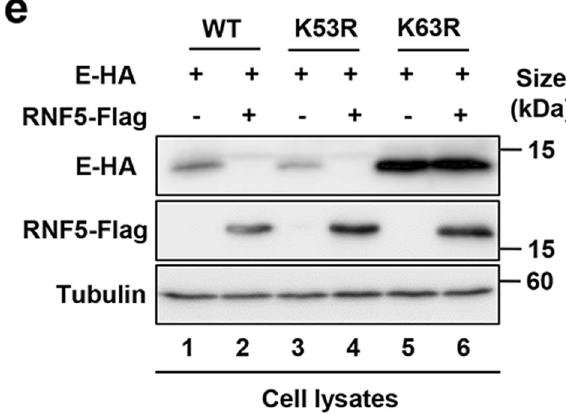
Fig. 3e The EK63R mutant was recalcitrant to RNF5-mediated